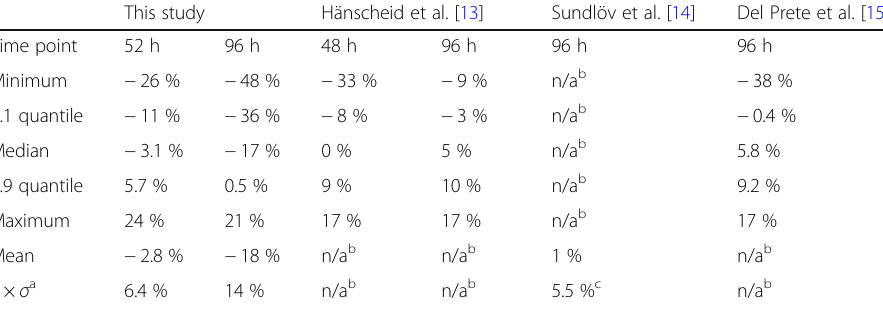
Table 2 Deviations of renal absorbed doses using one single measurement for [ 177 Lu]Lu-PSMA I&T (this study) and [ 177 Lu]Lu-DOTATATE/DOTATOC (literature) This study Hänscheid et al. [13] Sundlöv et al. [14] Del Prete et al. [15]